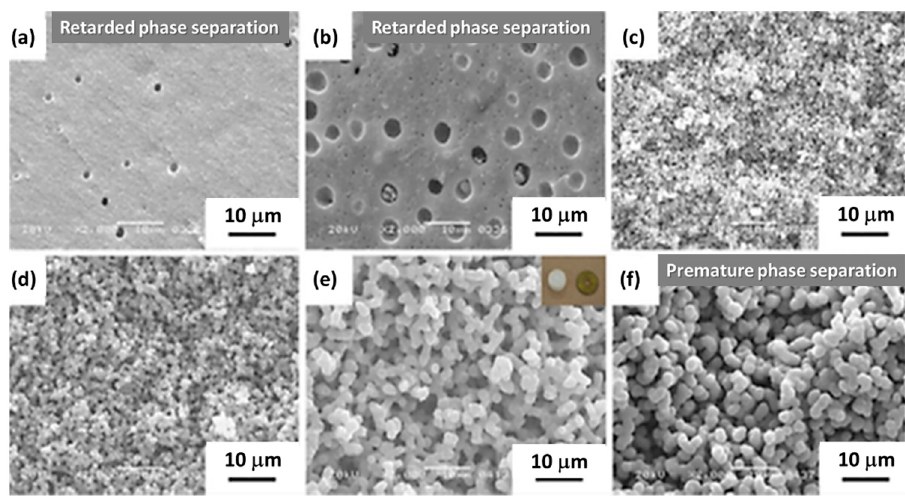
Figure 13. SEM photomicrographs of the dried TiO 2 gels prepared with different PVP contents (x): ( a ) 50 mg; ( b ) 70 mg; ( c ) 90 mg; ( d ) 100 mg; ( e ) 110 mg; ( f ) 115 mg (quantities used in the formulation: 0.5 g TiOSO 4 · xH 2 O: 1 mL H 2 O: 0.3 mL EG: 0.248 mL formamide: x mg PVP). Reprinted by permission from Springer Nature Customer Service Centre GmbH: Springer, J. Sol-Gel Sci. Technology, Sol-gel synthesis of macroporous TiO 2 from ionic precursors via phase separation route, Li W, Guo